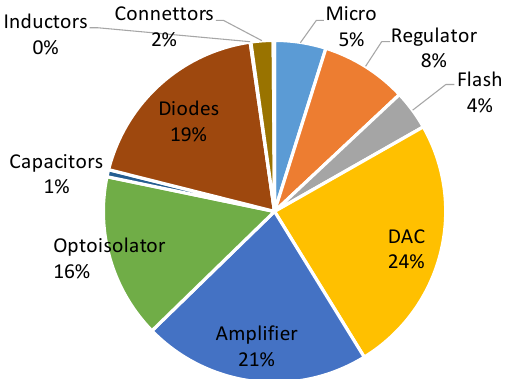
Figure 12. Contribution to the failure rate of the Control_new board of the different types of components, derived from model predictions.